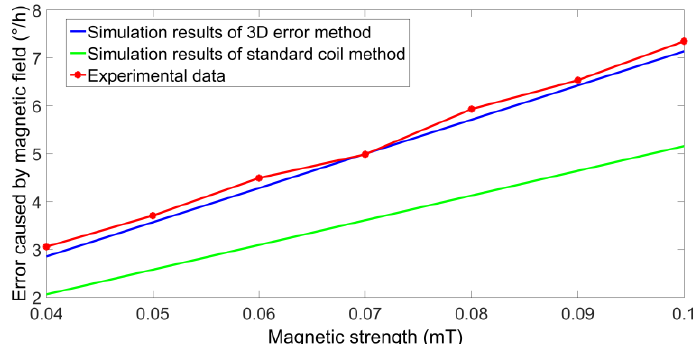
Figure 10. The comparison between the simulation results and the experimental results of the radial magnetic induced errors of the two error methods.